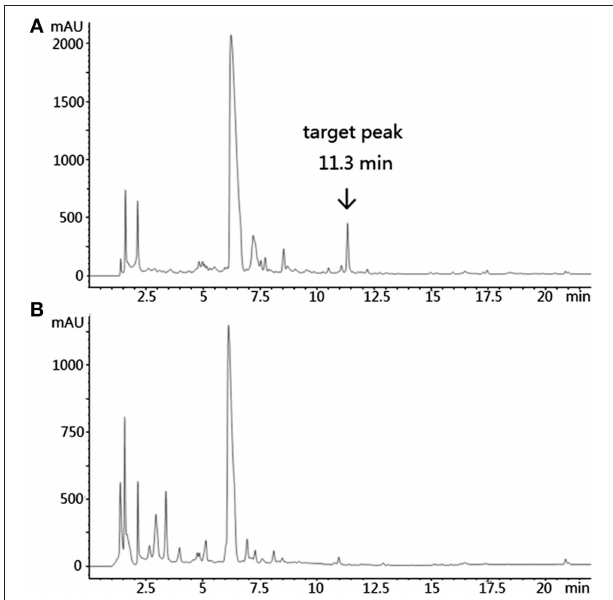
FIGURE 3 | HPLC of the ethyl acetate extract of S. anulatus S71 fermentation broth. Target peak was eluted at 11.3min (A) . HPLC of the